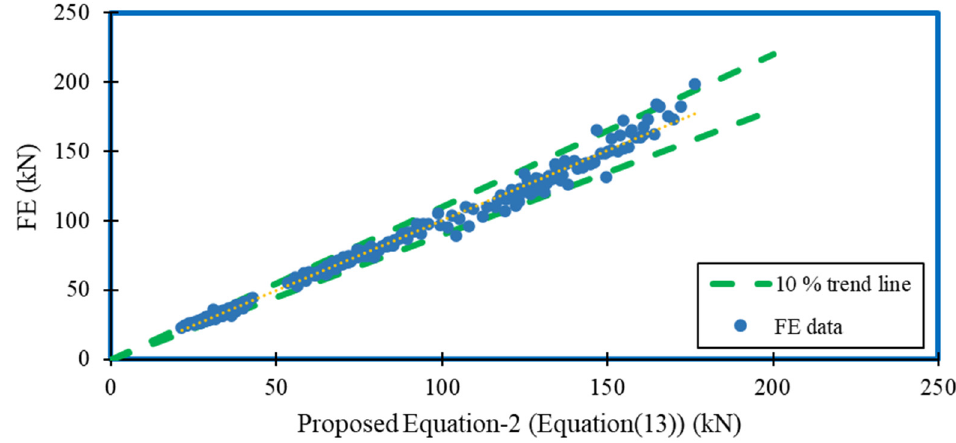
Figure 25. Comparison of parametric results and proposed Equation-2 (Equation (13)).